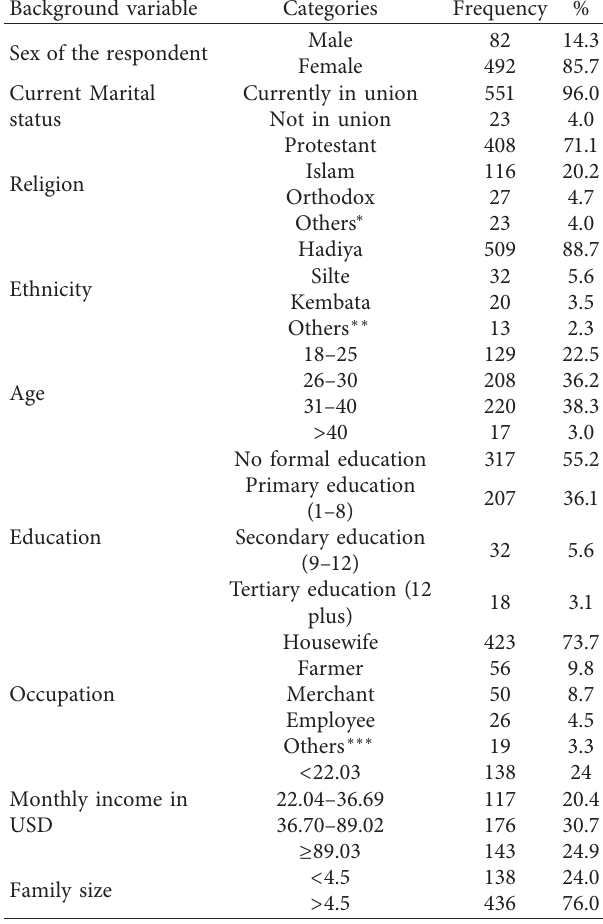
Table 1: Sociodemographic characteristics of respondents, Hadiya zone, Ethiopia, June 2018 ( n �